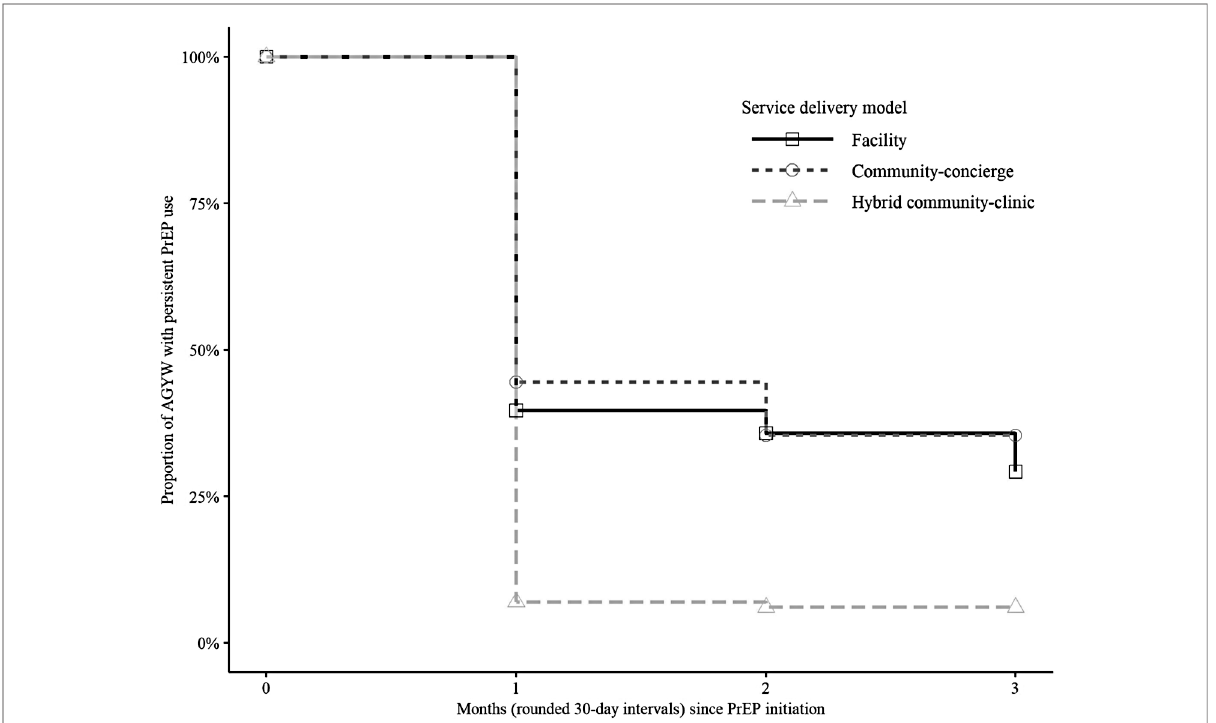
FIGURE 1 PrEP persistence (interrupted or uninterrupted) beyond three months among AGYW who initiated PrEP by service delivery model. Kaplan – Meier survival curves were used to estimate the cumulative probability of PrEP persistence beyond three months after PrEP initiation by service delivery model. AGYW who initiated PrEP during the study period ( N =1994) are included in the analysis. The marks on the curve indicate censoring and curves drop down when PrEP non-persistence ( “ failure ” ) events, de fi ned as discontinuation of PrEP with no subsequent re fi ll within three months after PrEP initiation,